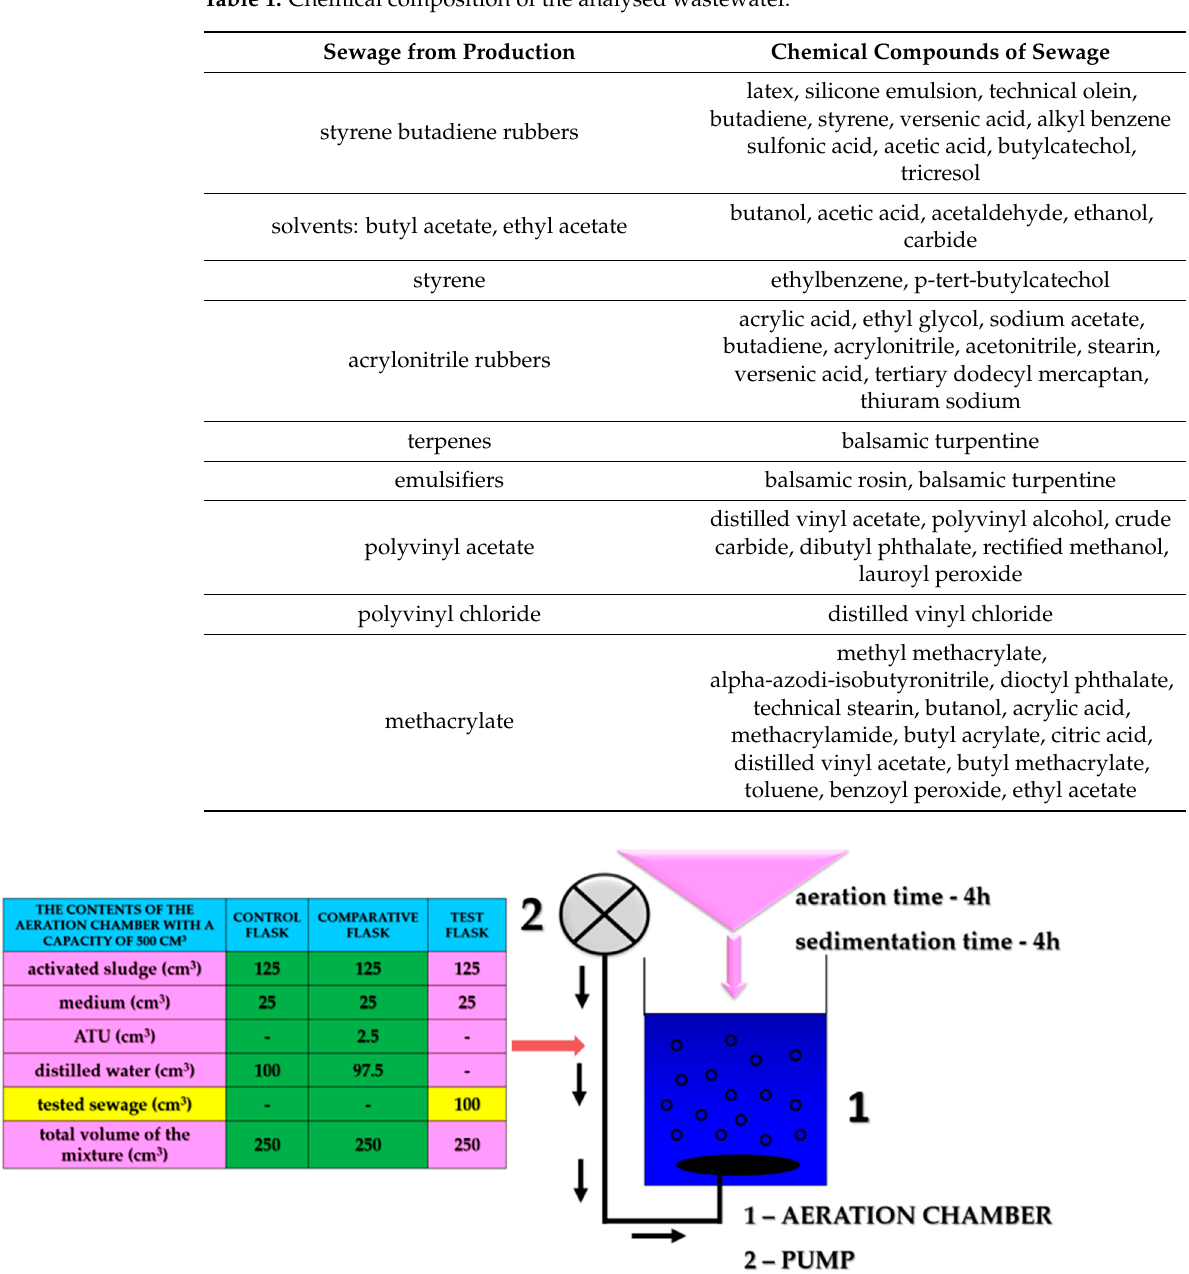
Figure 2. Assessment of the inhibitory effect of industrial wastewater on the nitrification process– experiment scheme. Table 2. Technological parameters of the activated sludge used for the research.